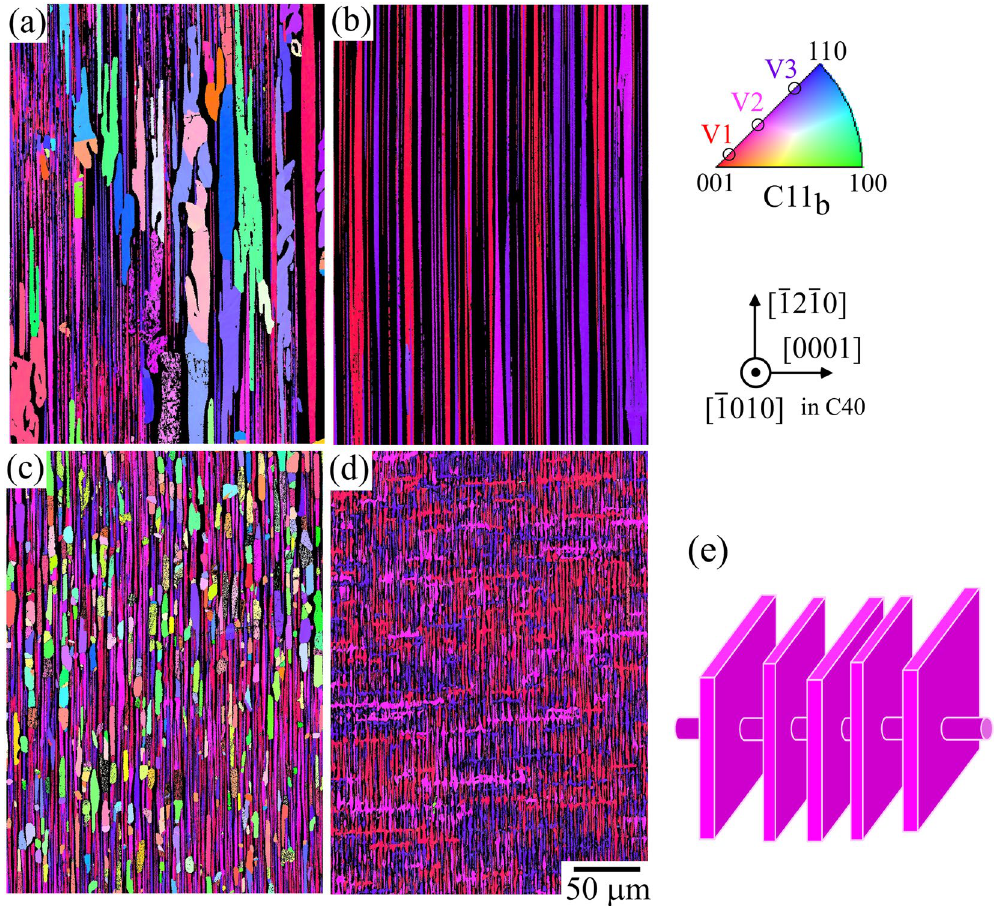
Figure 1. Microstructure variations depending on the added element. ( a – d ) Crystal orientation maps of the constituent C11 b phases in the FZ-grown crystals annealed at 1400 °C for 168 h examined by SEM-EBSD, according to the previous study 26 . ( a ) Nonadded (Mo 0.85 Nb 0.15 )Si 2 ternary crystal, ( b ) 1 at.% Cr-added crystal, ( c ) 1 at.% Ir-added crystal, ( d ) 0.5 at.% Cr and 0.5 at.% Ir-coadded crystals. ( e ) Schematic of the shape of the C11 b -phase grains formed the “cross-lamellar” morphology in the CrIr-added crystal. Noting that in Fig. 1(a–d) the crystal orientation map was analyzed along a direction rotated towards [11 2 0] by 15° from the observed [10 1 0] direction, to distinguish the orientation colors of the three variant C11 b -phase